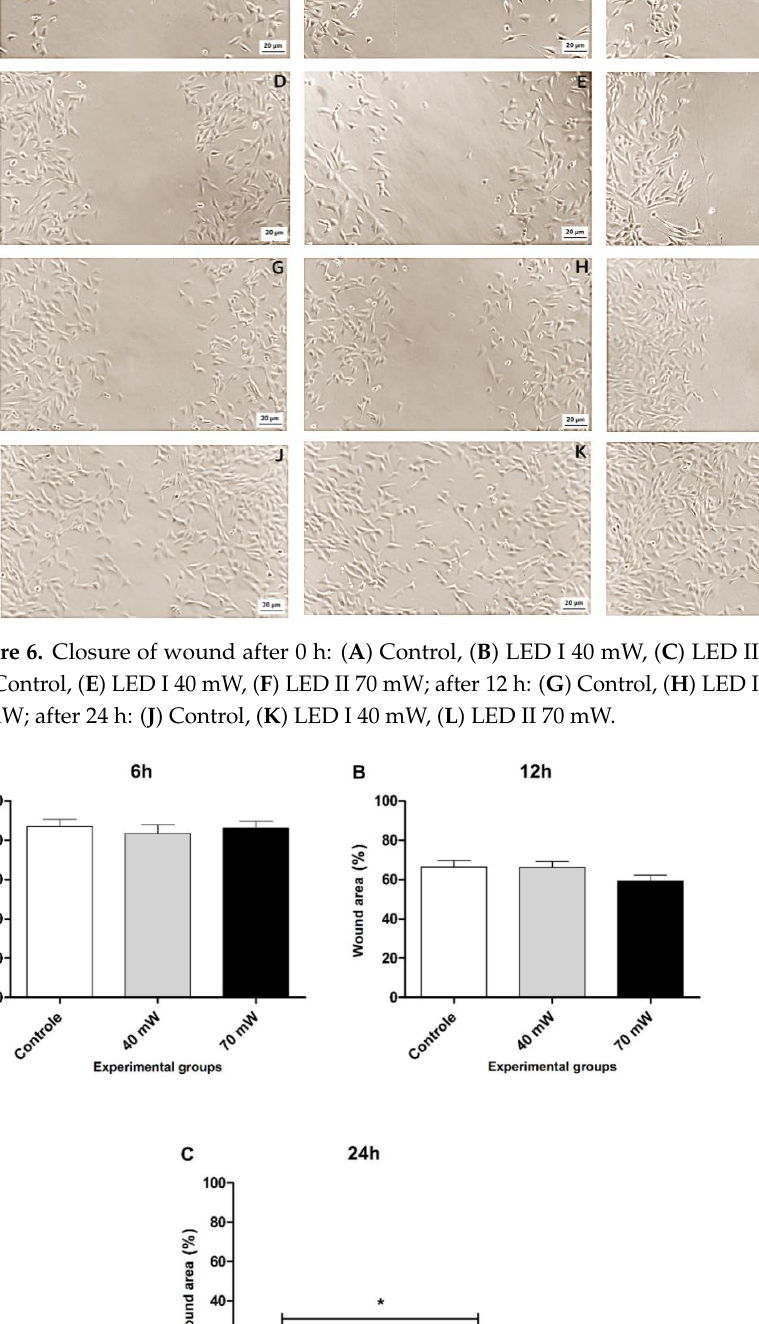
Figure 7. Wound area closure ( A ) 6 h, ( B ) 12 h, and ( C ) 24 h after to perform the scratch wounds and the irradiation with LED (ANOVA/Tukey); * p < 0.05 vs. control .